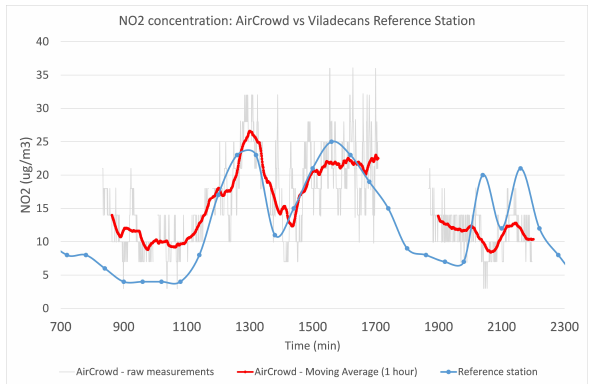
Figure 5. NO2 concentration: AirCrowd sensor node